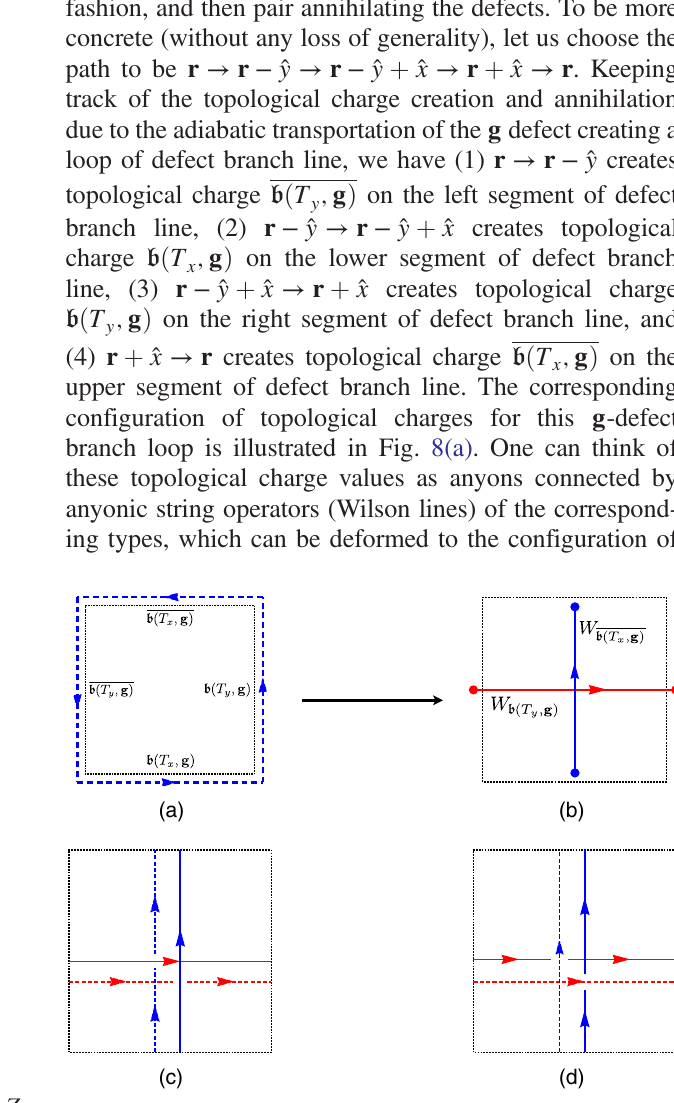
FIG. 8. Physical interpretation of the contribution to the obstruction from the anyonic spin-orbit coupling from topological charge per directed unit length of defect branch lines. (a) Pair creating a g - ¯ g defect pair, adiabatically transporting the g defect counterclockwise along a path enclosing a unit cell, and then annihilating the defects generates a loop of g -defect branch line encircling the unit cell (dashed blue line). This applies local g action U on the unit cell. Each edge of the unit cell can then be . g T x associated with a topological charge, as indicated in the figure. (b) The topological charges associated with each edge of the unit cell can be obtained by applying Wilson lines in the horizontal to Z and vertical directions, as shown. The precise manner in which the crossing point is resolved does not affect the final result. (c) The configuration of anyon strings associated to the process U U . Solid lines correspond to the U process and dashed lines g h g to the U process. (d) The configuration of anyon strings h U associated to the process U h g